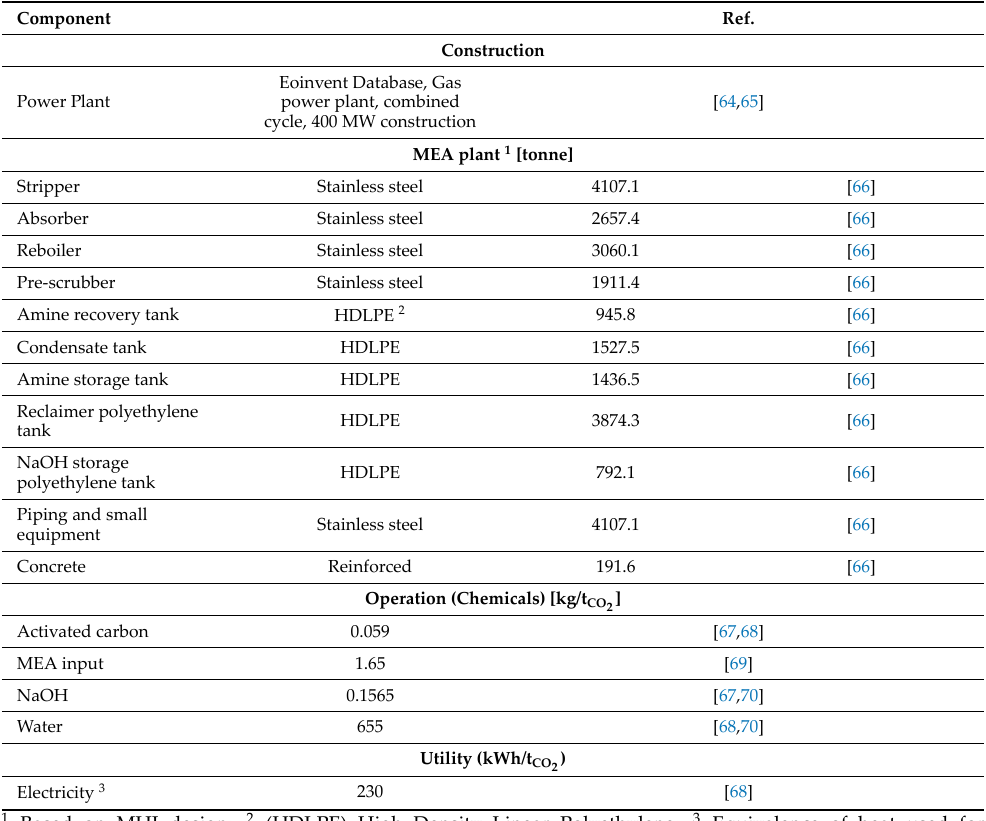
Table 4. Basic components used in the power plant and MEA capture plant in this